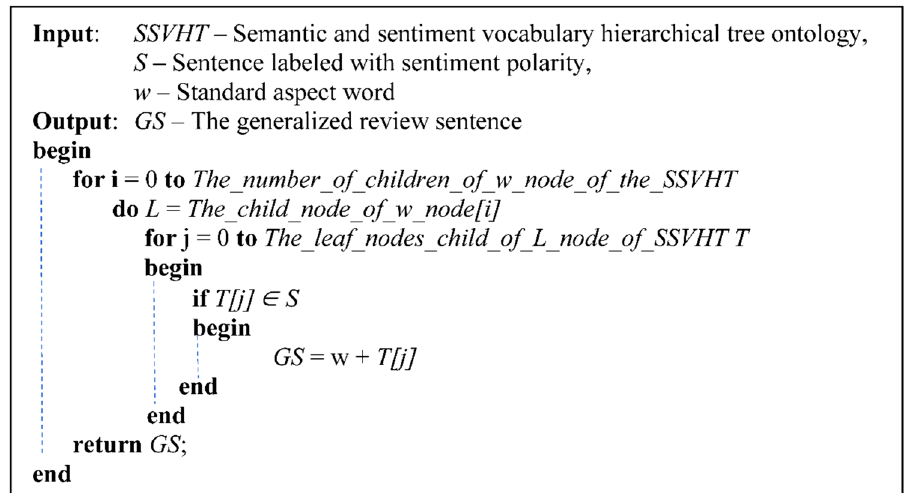
Figure 4. Generalization of opinions by the algorithm.